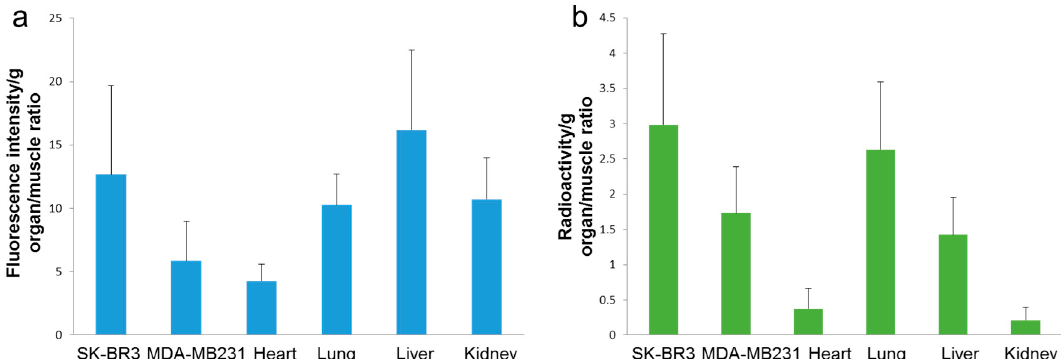
Figure 11. ( a ) Fluorescence intensity from the individual organs of the mice on 99m Tc-DTPA dual-imaging probe studies; ( b ) Radioactivity from the individual organs of the mice on 99m Tc-DTPA dual-imaging probe studies.